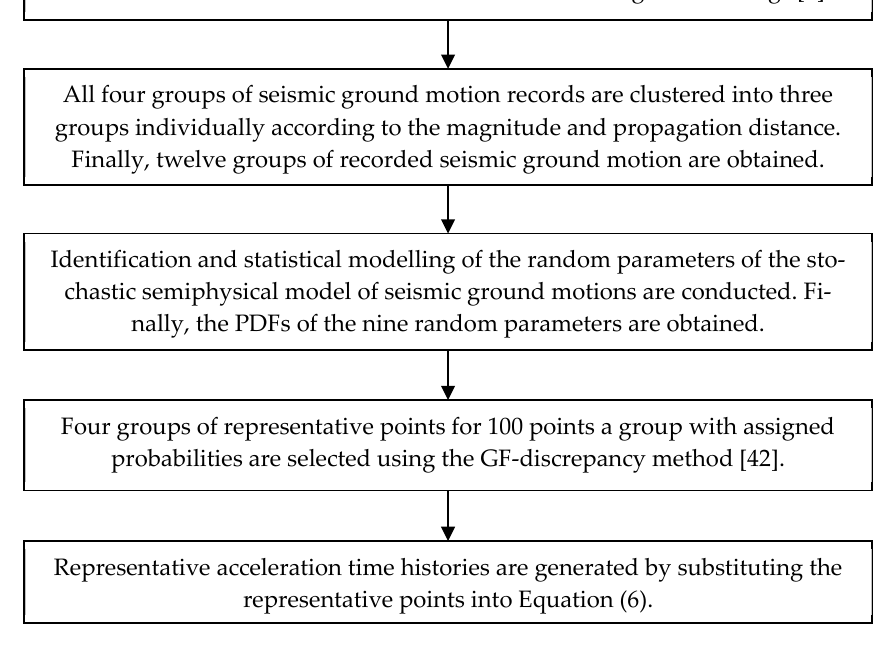
Figure 1. Synthesis of stochastic seismic ground motions.